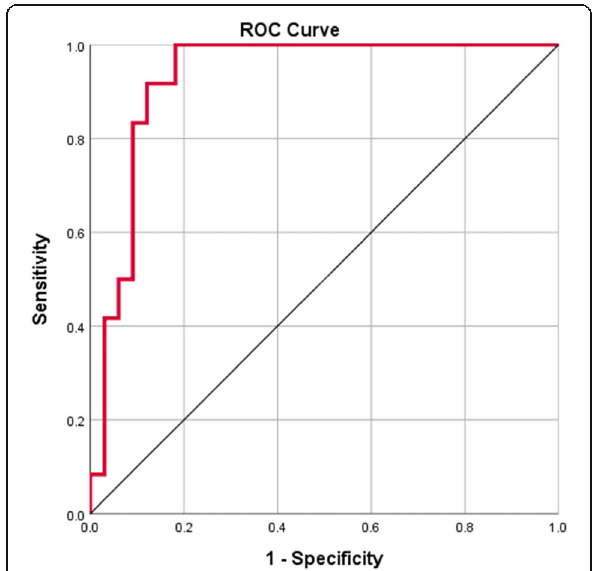
Fig. 2 ROC curve analysis of the relative elevation of the NT-proBNP in relation to the relative reduction of the GLS (>15%), AUC = 0.929 and p